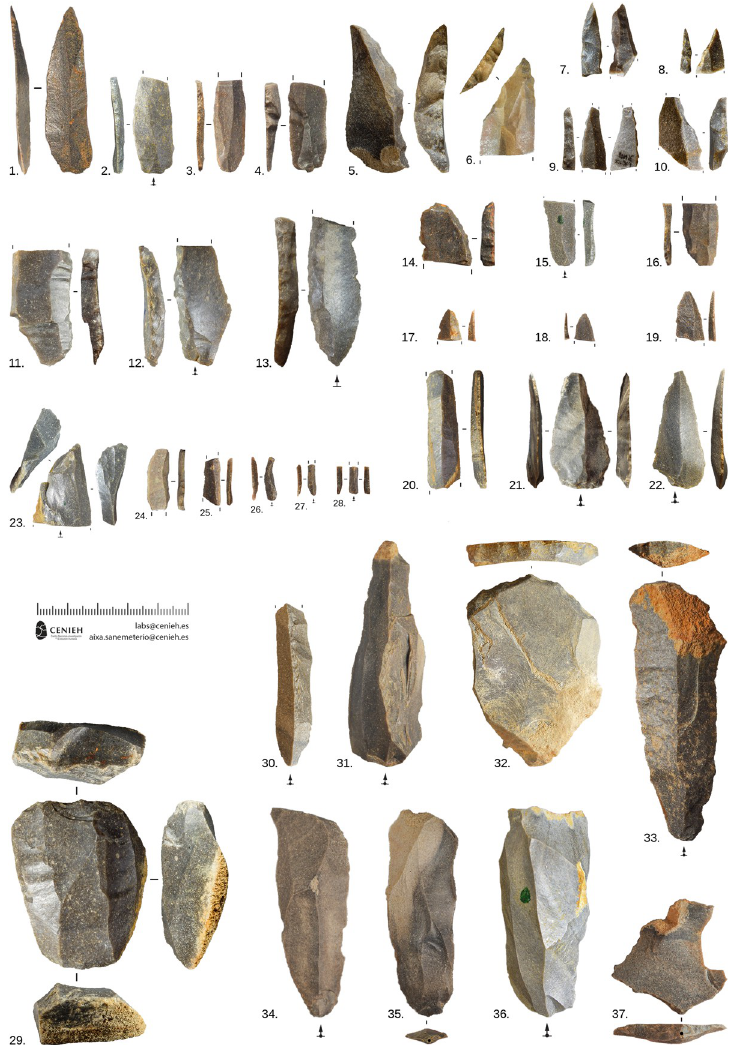
Fig 5. Chaˆtelperronian lithic assemblage. Aranbaltza II, US4b (Chaˆtelperronian) archaeological materials. 1) Complete thin Chaˆtelperronian point; 2–4) Proximal fragments of thin Chaˆtelperronian points; 5) Thick Chaˆtelperronian point, with the point made in the proximal part; 6) Distal fragment of wide Chaˆtelperronian point; 7–10) Distal fragments of Cha ˆ telperronian points: #9 exhibits axial diagnostic impact fracture; 11–13) proximal fragments of backed blades, possible Chaˆtelperronian points; 14) Distal fragment of backed blade; 15,16,20) Fragments of marginally backed blades; 17–19) Distal fragments of marginally backed points; 21–22) Marginally backed points; 23) Nucleiform burin; 24–28) Backed bladelets; 29) Bidirectional blade core for the production of pointed blades; 30– 31) Unidirectional crested blades; 32) Endscraper on natural fragment; 33) Endscraper on blade; 34–35) Blades; 36) Overshot blade dragging an opposed platform; 37) Platform rejuvenation flake. Figure made by Aixa San Emeterio and Joseba Rios-Garaizar. sections for the production of asymmetrical blades (S26 Fig in S1 File: 2). All the bladelet cores are unidirectional: five of them are nucleiform burins (Fig 5: 23; S28 Fig in S1 File: a; S29 Fig in S1 File: 1–2), and the other five have been made on blocks (S28 Fig in S1 File: b, c; S29 Fig in S1 File: 3, 4 and 6). These cores have produced narrow (ca. 4 mm) bladelets and are similar to the bladelet production described in Quinc¸ay (Fig 2: 24–28; S28 Fig in S1 File: 1–19) [26]. Blanks are dominated by narrow (6.4–13.5 mm width) and wide ( > 13.6 mm) blades and